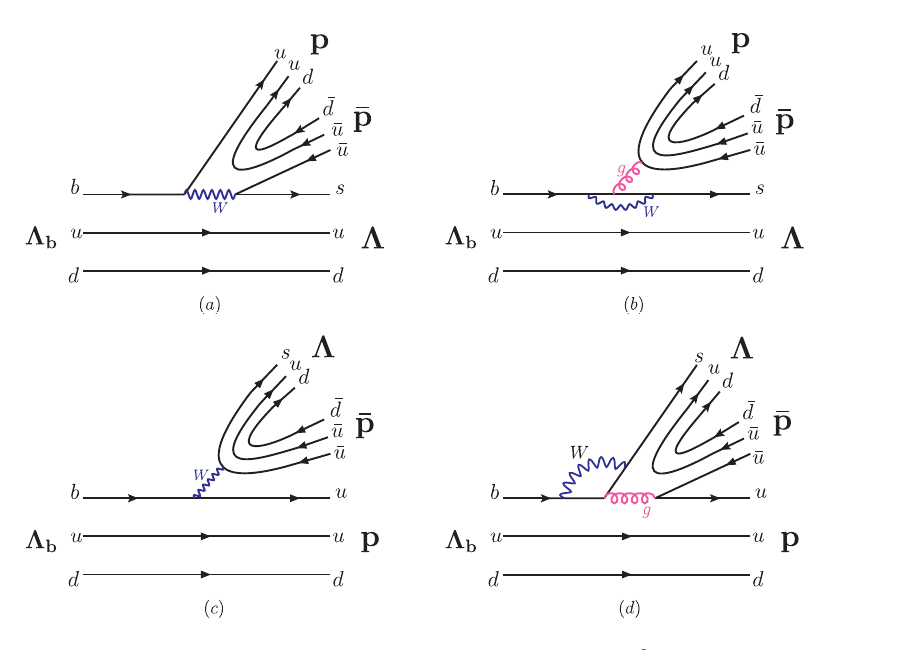
Figure 1. The dibaryon invariant mass spectra for the ( a ) Λ → Λ pp